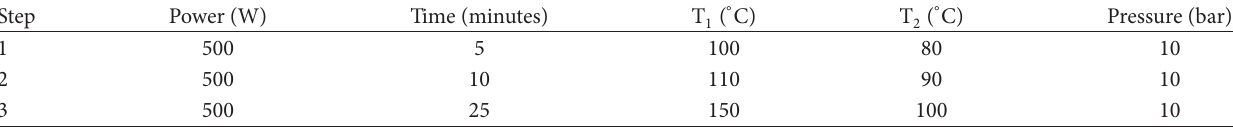
T 7: Detailed digestion conditions selected for digestion of samples in microwave digester.